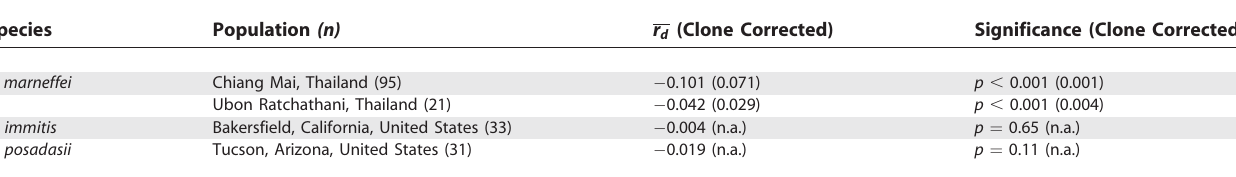
Table 2. Multilocus Linkage Disequilibrium for P. marneffei and Coccidioides spp.